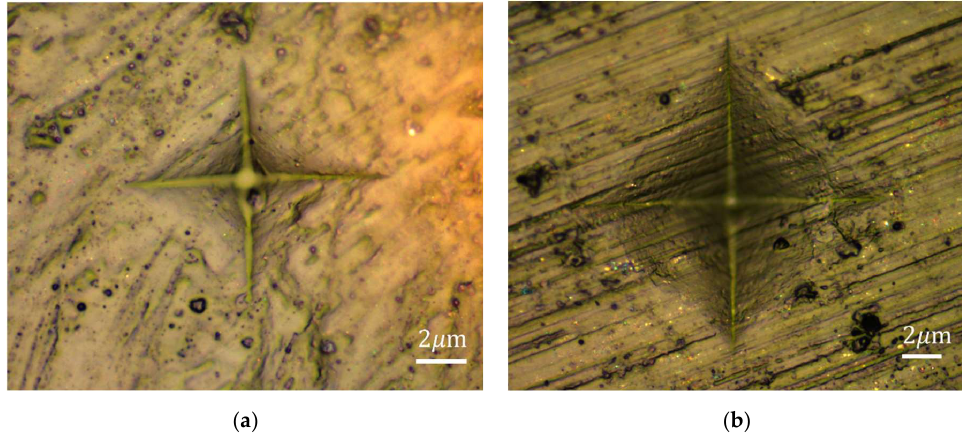
Figure 13. Vickers hardness indentation of ( a ) PMMA; ( b ) ZnAl 2 O 4 : Mn/GO/PMMA.